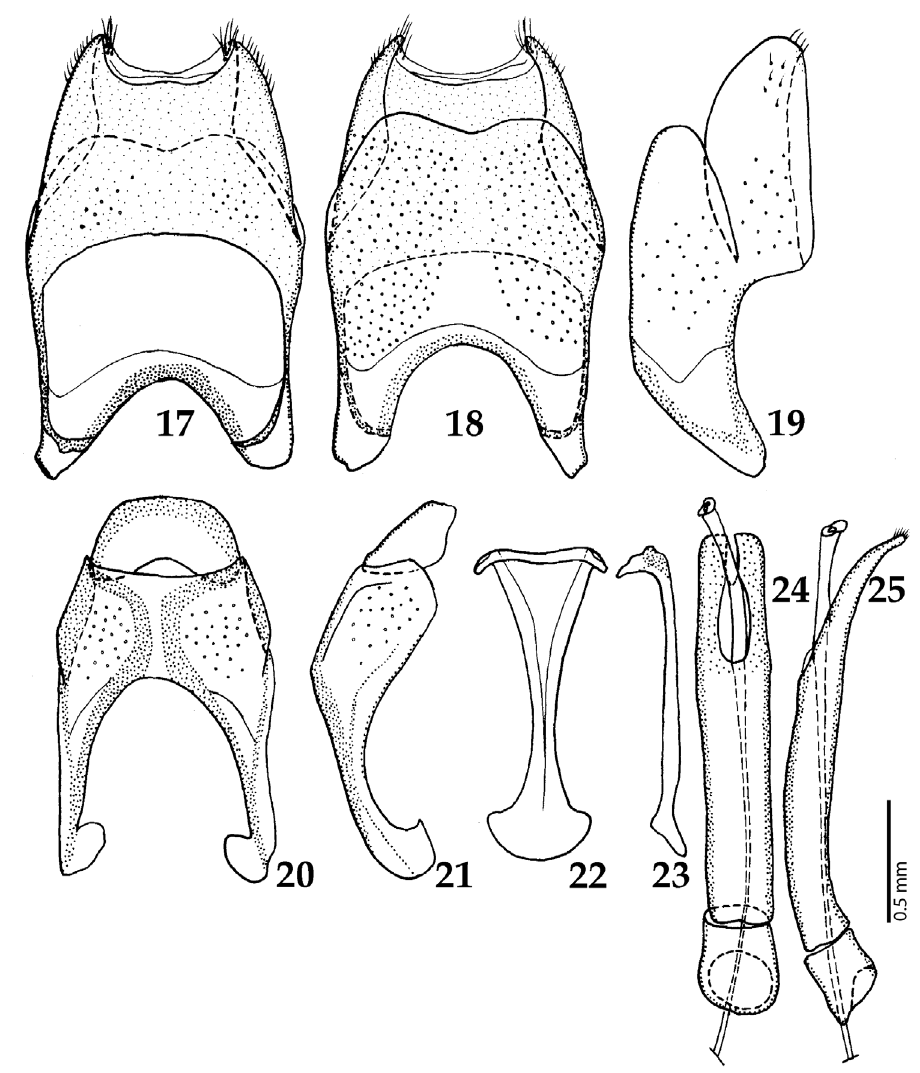
Figures 17–25. 17 Australopachylopus lepidulus (Broun, 1881) comb. n., male terminalia: 8 th sternite + 8 th tergite, ventral view 18 ditto, dorsal view 19 ditto, lateral view 20 male terminalia: 9 th + 10 th tergites, dorsal view 21 ditto, lateral view 22 male terminalia: spiculum gastrale, ventral view 23 ditto, lateral view 24 male terminalia: aedeagus, dorsal view 25 ditto, lateral view. shallow dense setigerous punctures; metepisternum + fused metepimeron (Fig. 10) with even denser and coarser setigerous punctures, separated by less than half of their diameter; lateral metepisternal stria